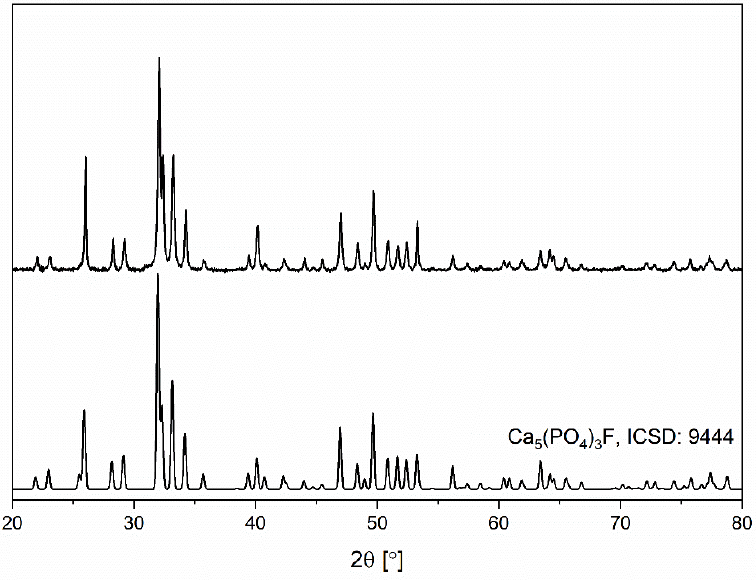
Figure 1. Powder diffractogram obtained for nanofluorapatite heat-treated at 450 °C for 6 h.